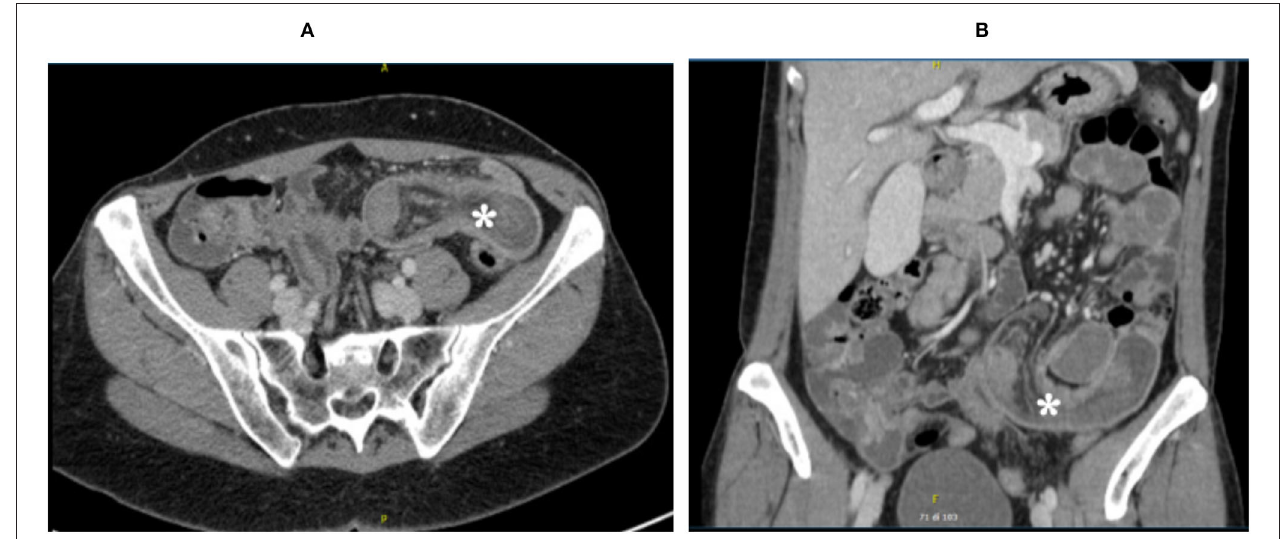
FIGURE 1 | Abdominal CT scan: *indicates the ileo-ileal intussusception. (A) CT transverse section. (B) CT coronal section.